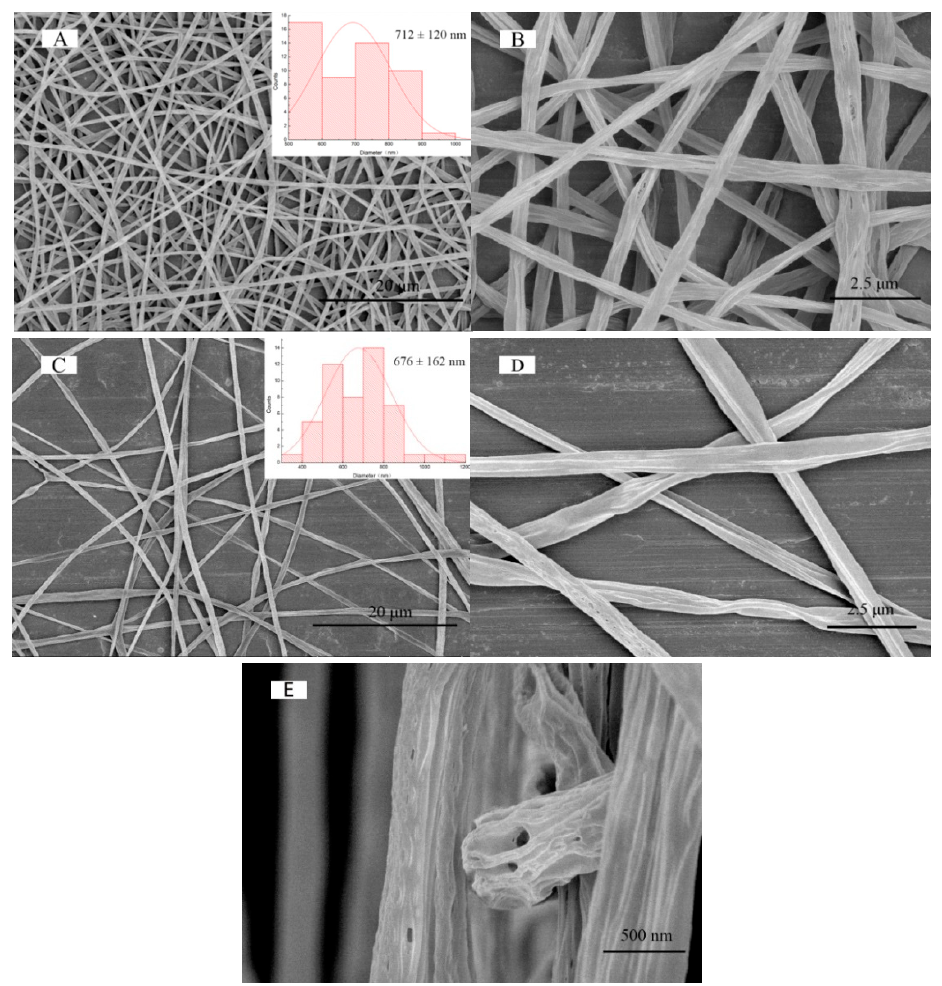
Figure 2. Scanning electron microscopy (SEM) micrographs at different magnifications of ( A , B ) shell and ( C , D ) coaxial electrospun nanofibers; and ( E ) the cross-section of coaxial electrospun nanofibers.